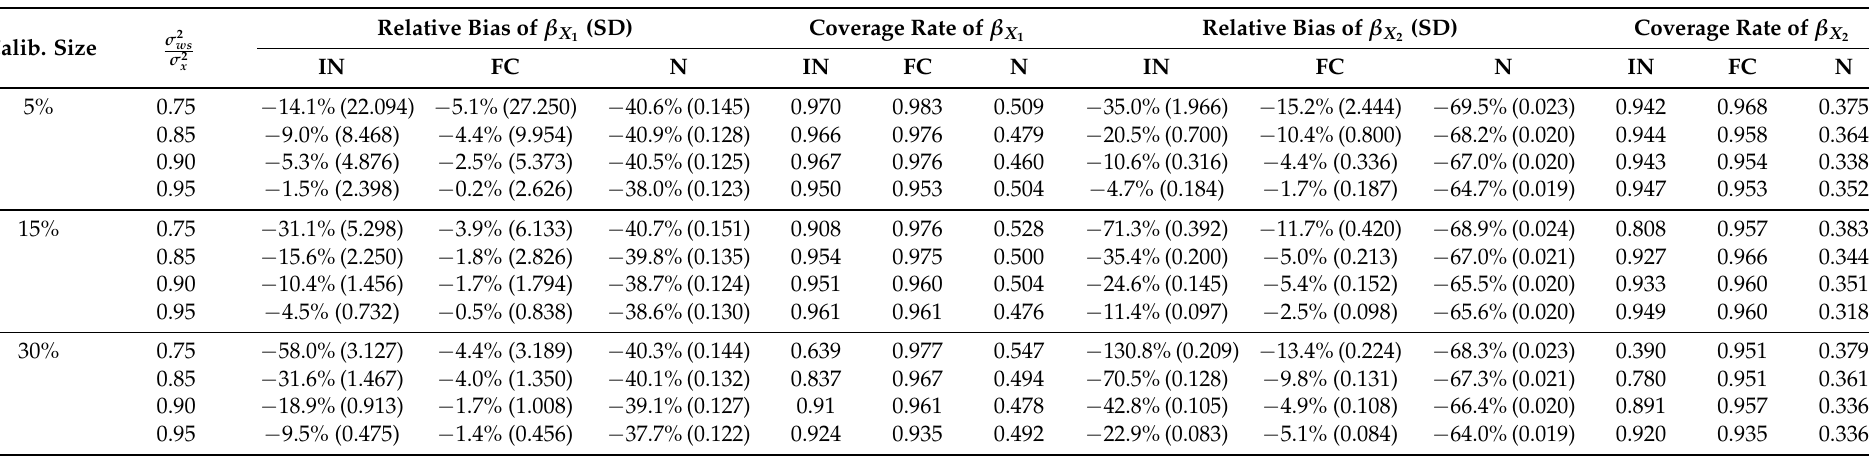
under the model P X 2 ws . Relative bias is computed using (cid:98) β σ 2 X